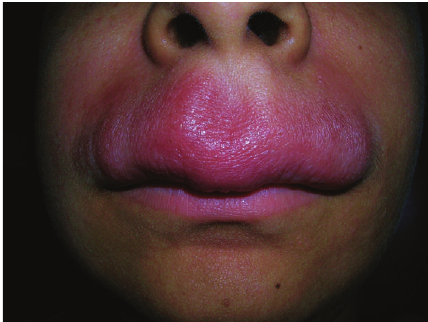
Figure 3: Posttreatment view of the first patient with marked improvement of swelling and erythema.